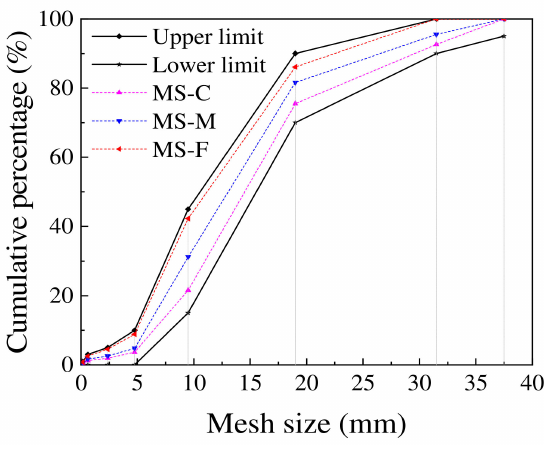
Figure 3. Manufactured sand aggregate gradation curve.